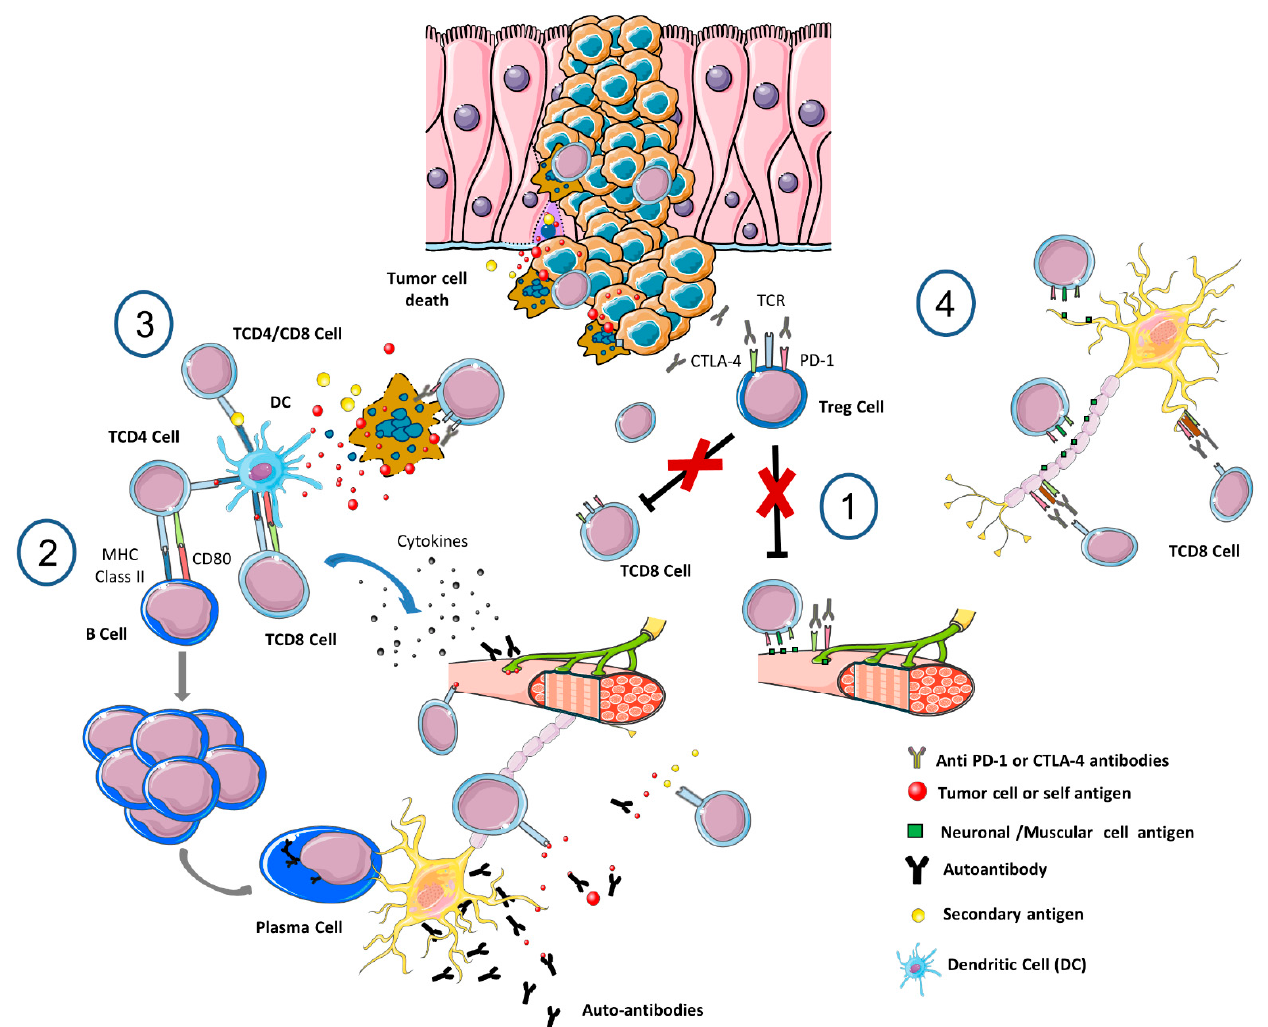
Figure 1. Potential pathological mechanisms underlying neurological immune-related toxicities (NirAEs). A: Hypothesis under ICI. (1) ICIs may induce Tregs reduction and shift the balance towards immune tolerance loss and immune toxicity development (2) The similarity between a neoantigen and a self-antigen might induce T- or B-autoreactive cells wrongly directed against self-antigens (molecular-mimicry) (3) Cytotoxic CD8+ T-cells evoke tumor cell death but also non-transformed bystander cells death. The antigens released by both types of cells (antigen spreading) might be ingested and processed by antigen-presenting cells (APCs) priming new T- or B-cells leading to a autoimmunity reaction (4) PD-1 and CTLA-4 antibodies could recognize their target molecules expressed by non-hematopoietic cells, like in the nervous system, and induce a local injury through antibodies or T-cell cytotoxicity mechanisms. Modified from Vilariño N et al. 2020 [127]. Breakage of the immune tolerance by the depletion of regulatory T (Tregs) cells [128], the loss of B-cell tolerance and subsequent changes in the cytokine profile. Both Tregs and B cells present CTLA-4 and PD-1 receptors; and proinflammatory cytokine profiles [129], and/or development of serum autoantibodies [130] have been identified in ICI-treated patients. The established role of Tregs depletion in experimental autoimmune encephalomyelitis and MS might also support the latter point of view [131]. Molecular mimicry and cross-reactivity between tumor and self-nervous system antigens is supported by multiple experimental and clinical studies [132]. The self- antigens might be released when tumor and peritumoral tissues are damaged by the